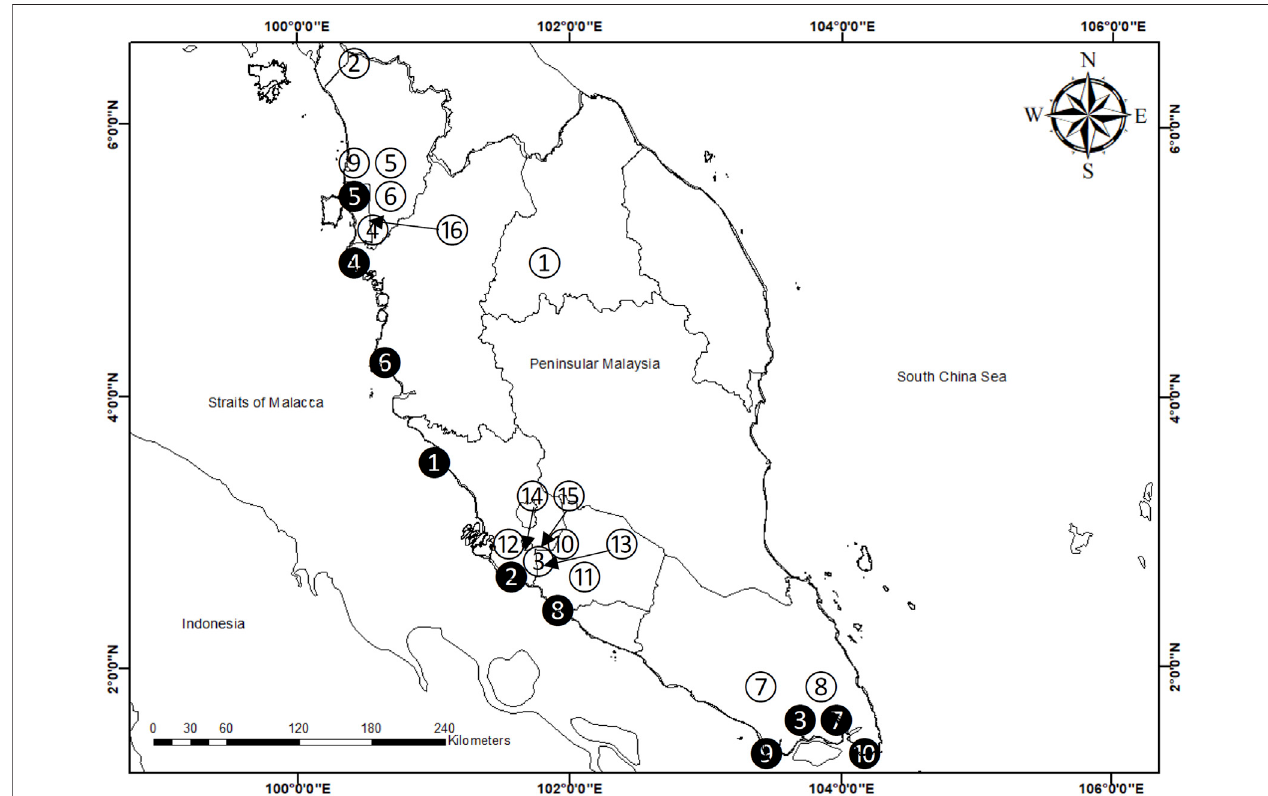
FIGURE 1 | Map showing the sampling sites in Peninsular Malaysia (See Supplementary Table S1 ). Note: numbers in black circles (1-10) are sampling sites (M1 – M10 in Supplementary Table S1 ) for mangrove sediments without collection of Centella asiatica ; numbers in white circles (1-12) are sampling sites (S1 – S12 in Supplementary Table S1 ) for C. asiatica with habitat topsoils; and numbers in white circles (13 – 16) are sampling sites (S12 – S16 in Supplementary Table S1 ) for topsoils only.